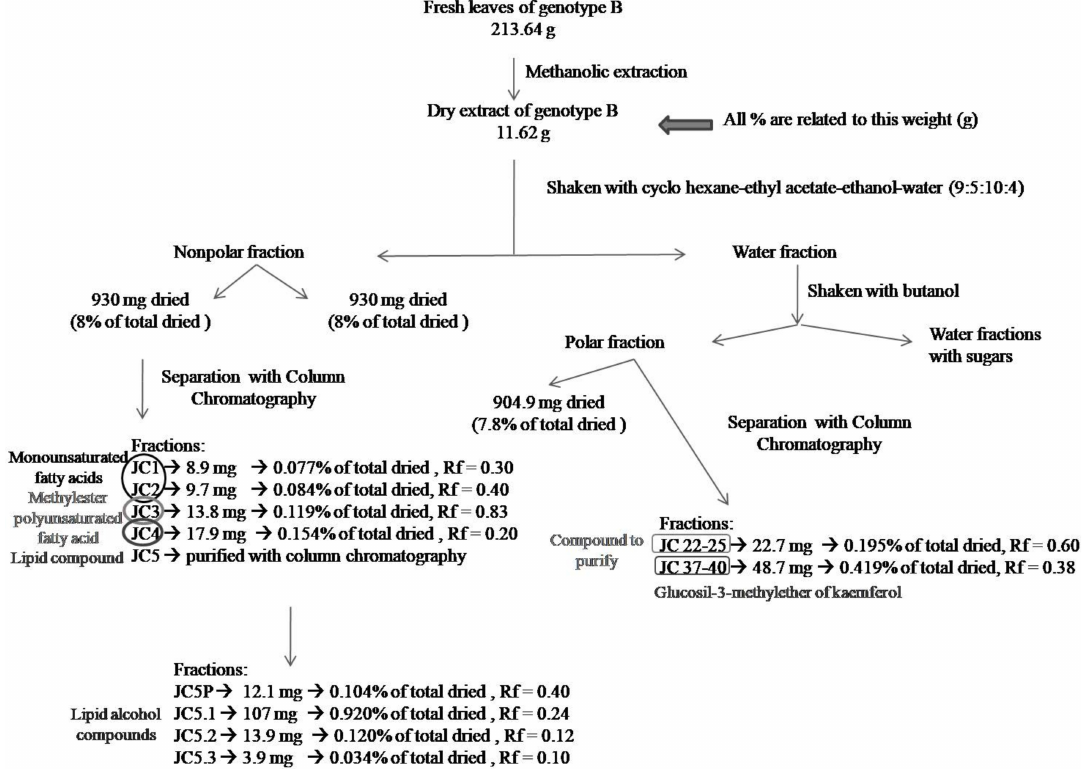
Figure 5. Separation pattern of the total extract of leaves of genotype B of J. curcas